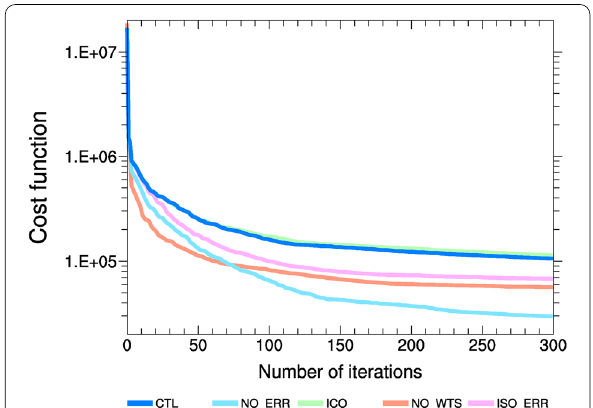
Fig. 4 Cost function changes with iterations for the CTL case (blue) and the other four sensitivity tests of NO_ERR (light blue), ICO (light green), NO_WTS (orange), and ISO_ERR